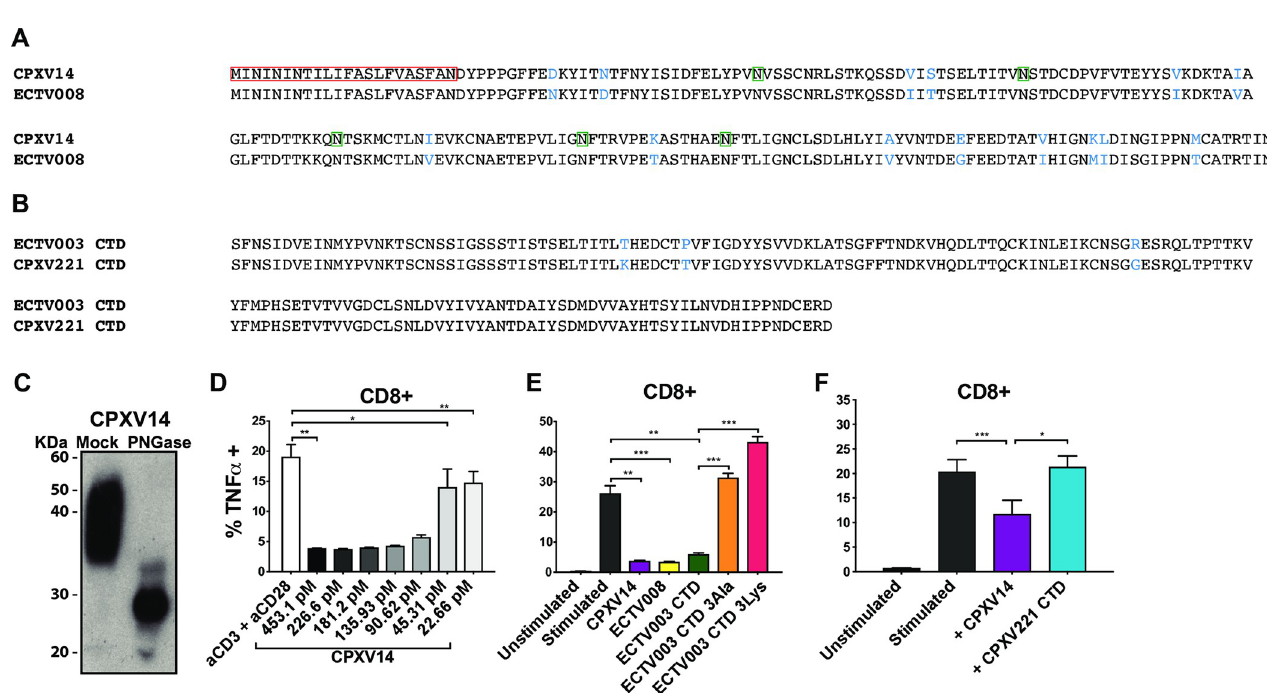
Fig 3. Poxviral SECRET-domain proteins inhibit T cell activation by plate-bound anti-CD3 and anti-CD28 antibodies. A) Alignment of CPXV14 with SECRET-domain containing protein-2 (ECTV008) of ectromelia virus (ECTV). Proteins were aligned using CLUSTAL O v1.2.1. The predicted signal sequence is highlighted with a red box. N-linked glycosylation sites were predicted with GlycolEP and are indicated in green. Amino-acid differences are shown in blue. B) Alignment of the SECRET-domain containing C terminal domain (CTD) of CPXV221 (CrmD) with that of the CrmD CTD in ECTV003. C) N-linked glycosylation of CPXV14-His. Immunoblot of purified, recombinant CPXV14-His without or with PNGase treatment. D) Recombinant CPXV14-His inhibits T cell activation by plate bound antibodies. Splenocytes from BALB/cByJ mice were incubated with recombinant CPXV14-His at the indicated concentrations for 4h prior to ICS. The mean TNF α response frequencies of CD8+ T cells from 5 mice are shown (+SEM). E) T cell inhibition by ECTV homologs of CPXV14 and CPXV221 is dependent on an intact SECRET domain. The indicated recombinant proteins were added to splenocytes of BALB/cByJ mice at a concentration of 1.1 μ M for 4h prior to ICS as in (C). Average frequencies of TNF α + CD8+ T cells are shown (n = 5, +SEM). F) The CTD of CPXV221 (CrmD) does not inhibit T cell activation. T cell inhibition by 1.1 μ M of CPXV14-His or his-tagged recombinant CTD of CPXV221 was examined as in (D). Average frequencies of TNF α + CD8+ T cells are shown (3 experiments, n = 3 each, +SEM). P values in D, E and F were calculated using paired two-tailed Student’s T test ( ��� p � 0.001, �� p � 0.01, � p � 0.05, NS = p > 0.05).